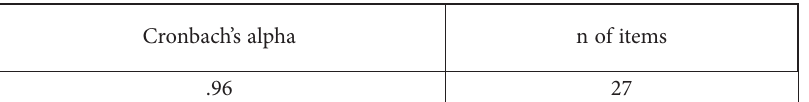
Table 1. Coefficient of internal compatibility for the general scale of socio-emotional competencies (source: created by authors) Cronbach’s alpha n of items .96 27